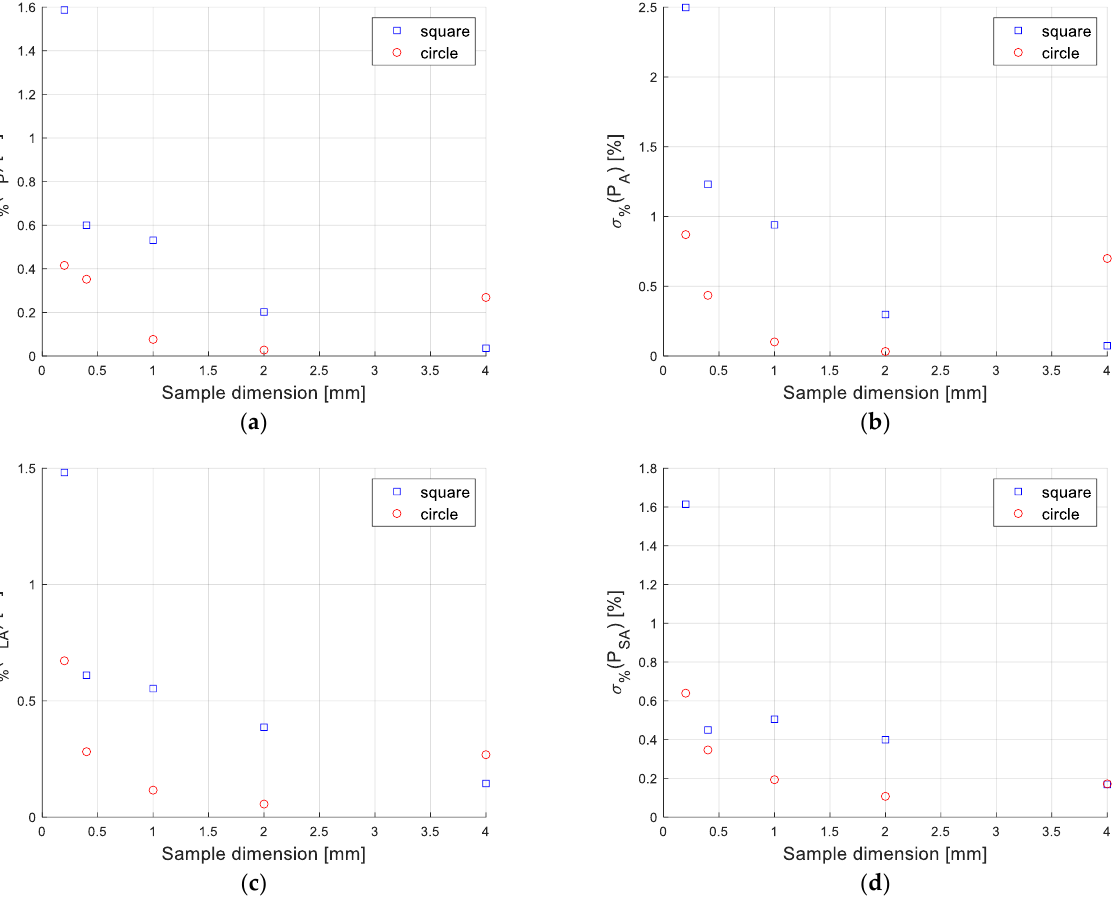
Figure 6. Repeatability of the system, in terms of the standard deviation, 𝜎 % (𝑃 𝑖 ) , of 𝑃 𝑖,𝑞 ( q for 10 repetitions) for each operating condition (two considered particle shapes and dimensions): ( a ) perimeter, ( b ) area, ( c ) long and ( d ) short axes.